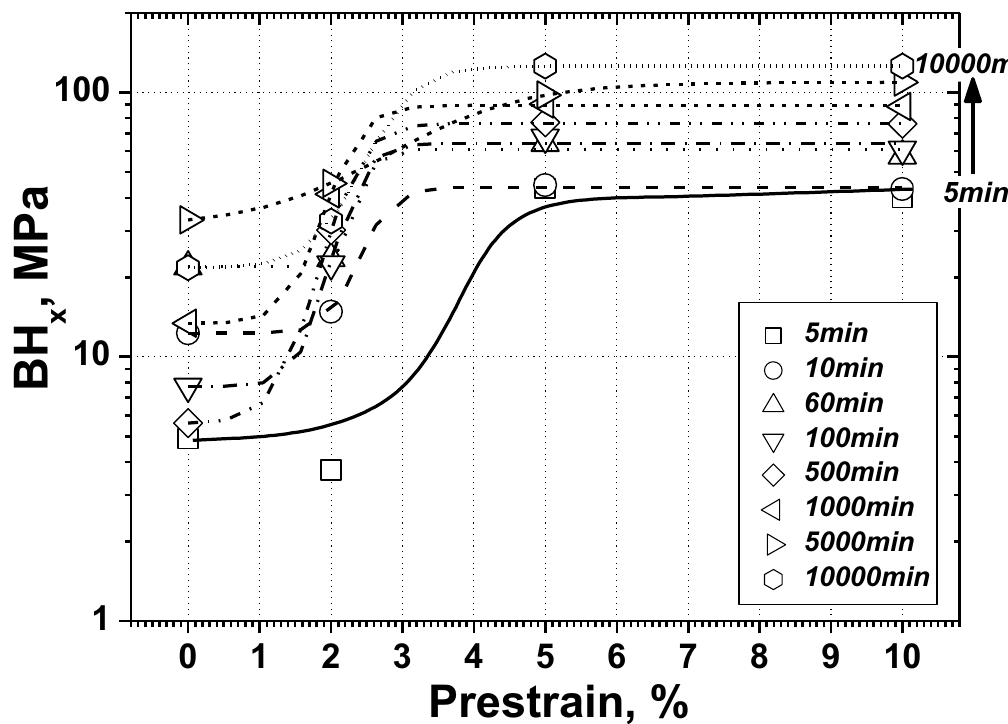
Figure 8. BH values versus 0%, 2%, 5%, and 5% prestrain for aging at 170 ◦ C from 5 to 10,000 min for the TRIP3